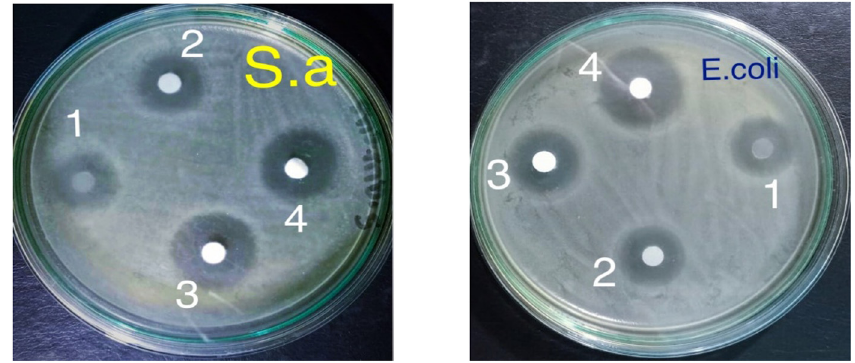
Figure 9: The antimicrobial activity of TiO 2 nanoparticles at di ff erent irradiation doses against S. aureus ( left ) and E. coli ( right